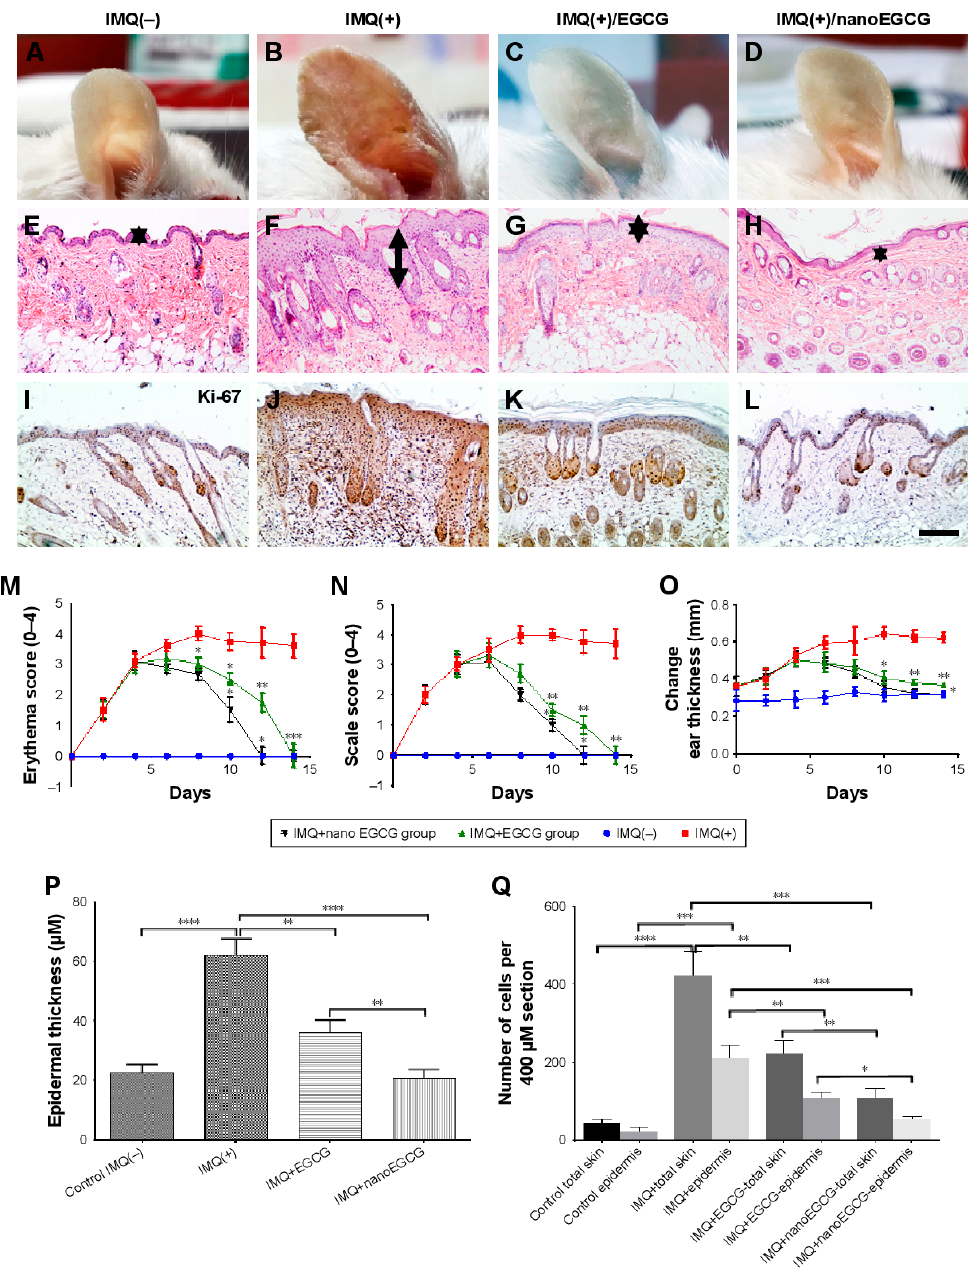
Figure 4. Comparison between topical free EGCG and nanoEGCG in terms of clinical efficacy and histological evaluation in IMQ-induced mice. ( A – D ) inflammation severity in mice ears. ( E – H ) H&E-stained sections of skin. ( I – L ) Ki67-stained sections of skin. ( M – Q ) quantitative evaluation of psoriatic features. * p < 0.05, ** p < 0.01, *** p < 0.001, **** p < 0.0001. Adapted from [33], Dove Medical Press, 2018.